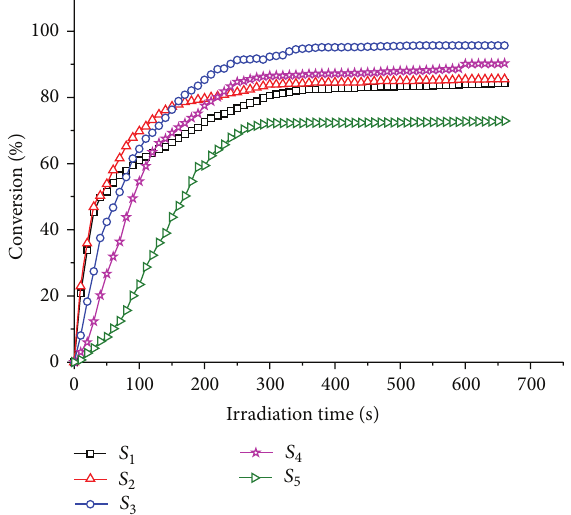
Figure 7: Effect of UV irradiation time on the conversion of UV- curable formulations with different UVCF content.